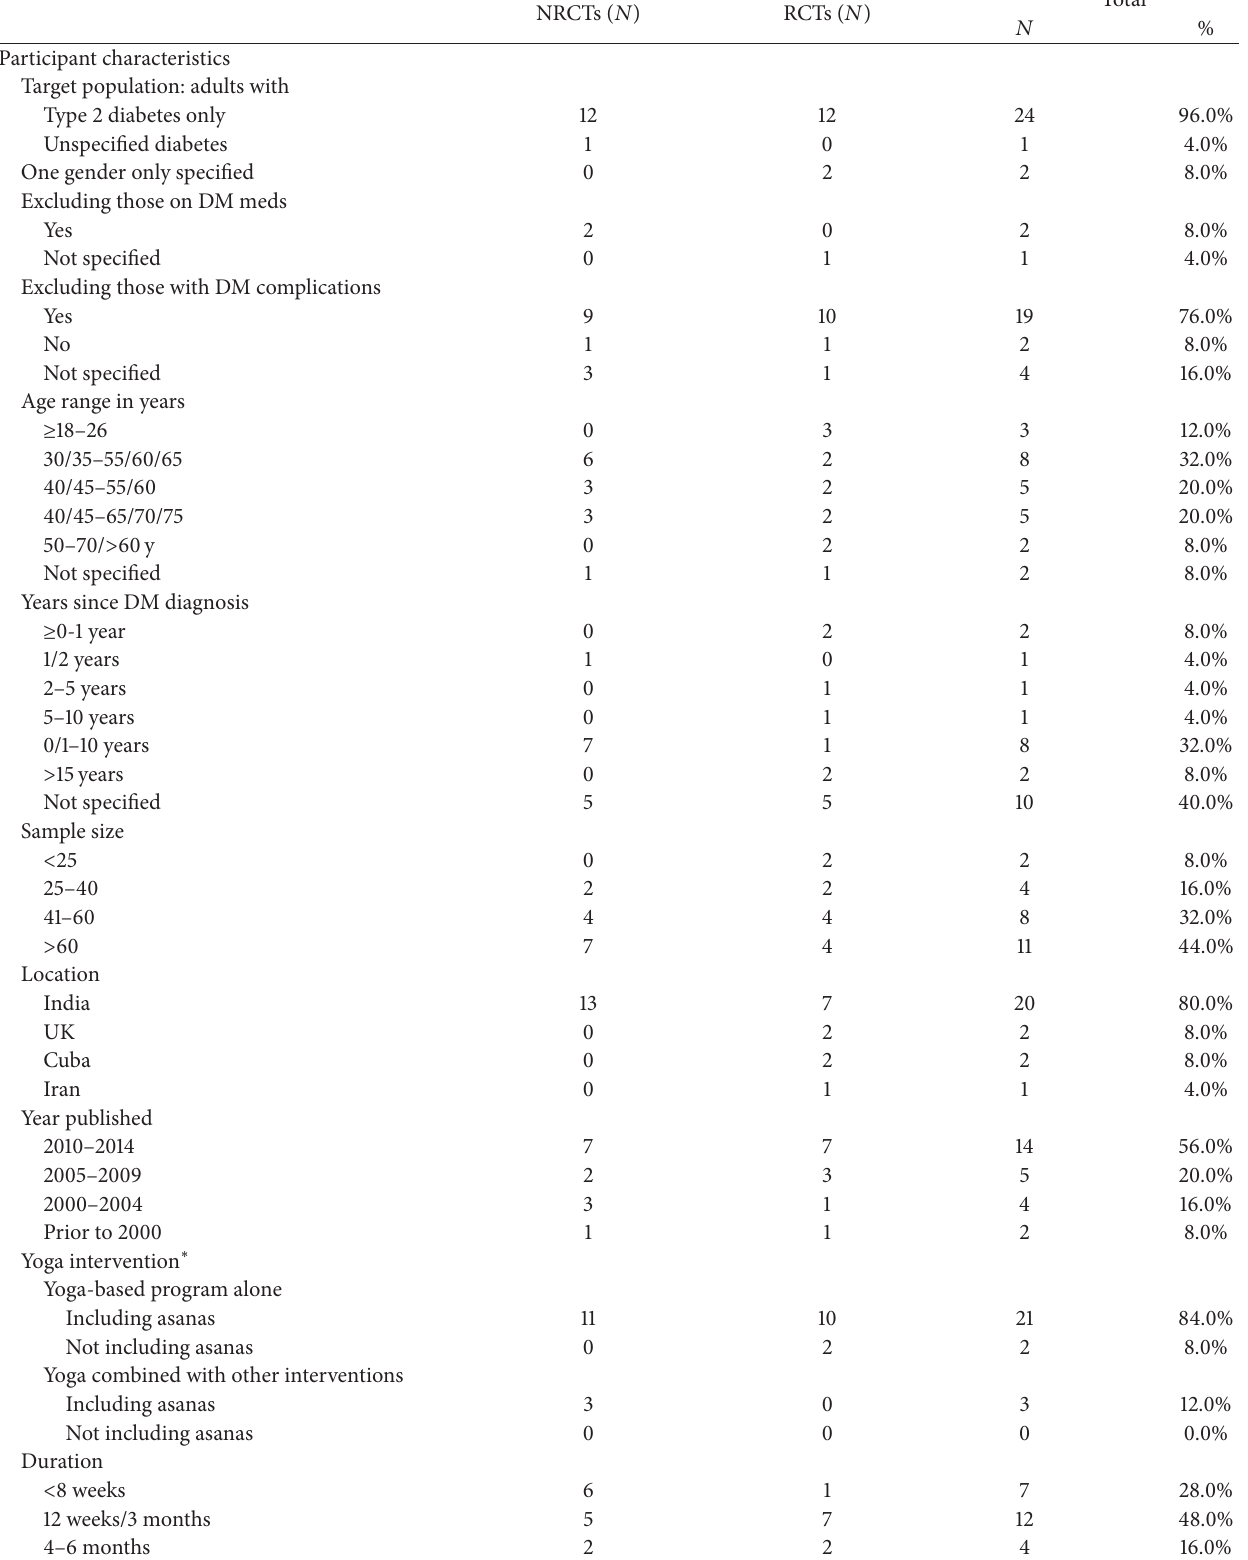
Table 1: Characteristics of eligible studies investigating the effects of yoga-based programs in adults with diabetes (25 controlled trials, including 12 randomized (RCTs) and 13 nonrandomized